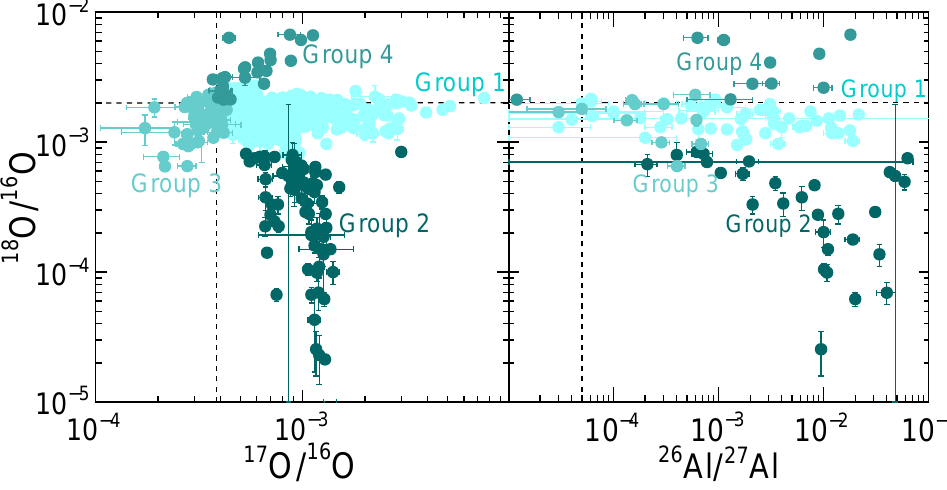
Figure 1. Left panel: oxygen isotopic ratios in presolar oxide grains. Labels and colors identify the grains belonging to different groups according to Nittler et al. [15]. The compositions and the stellar origins of group 1 and 2 grains are discussed in detail in the paper. Group 3 grains are supposed to reflect in their isotopic mix the evolution of the oxygen isotope abundances in the Galaxy, forming in low metallicity stars [21], while group 4 grains likely formed in supernovae [22]. Right panel: 18 O/ 16 O vs. 26 Al/ 27 Al isotopic ratios recorded in grains of the same sample. Different colors identify grains belonging the 4 groups. The black dashed lines indicate the solar values for the O and Al isotopic